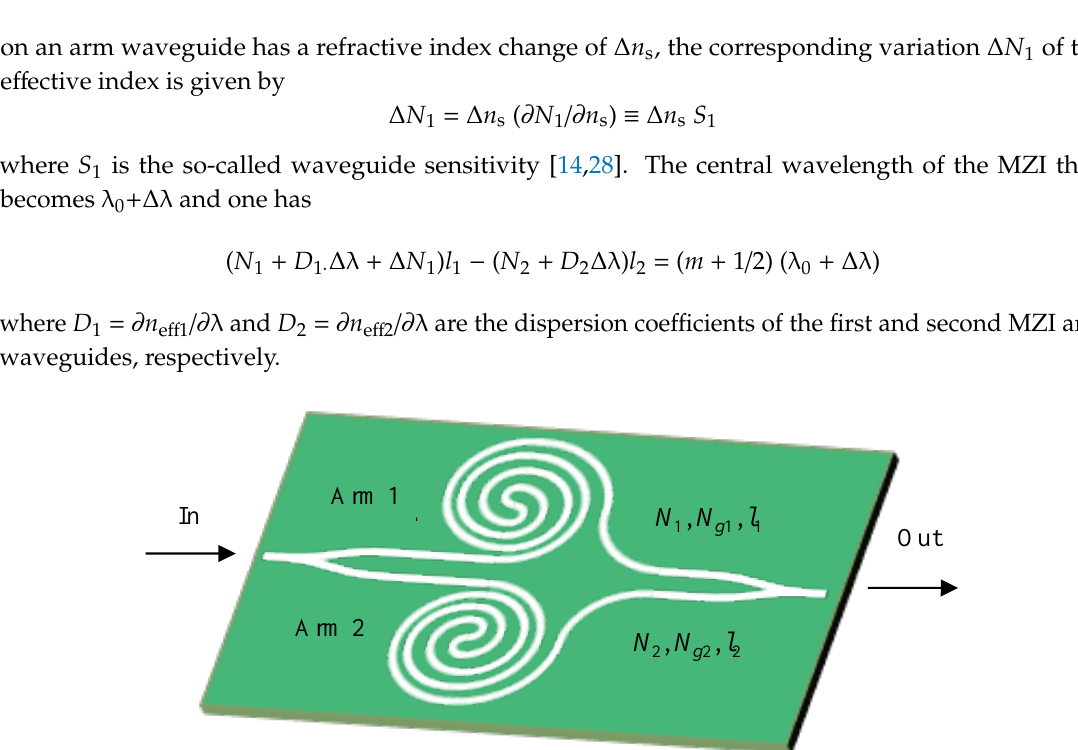
Figure 1. A Mach-Zehnder interferometer (MZI) sensor with optimal arm-lengths ( l 1 , l 2 ). Here, the arm lengths are given as l 2 = ( m +1/2)[ N 1 −( D 1 λ 0 +ε)]/[ N 2 ( D 1 +ε/λ 0 )− N 1 D 2 ], and l 1 = l 2 N g2 /( N g1 − ε).